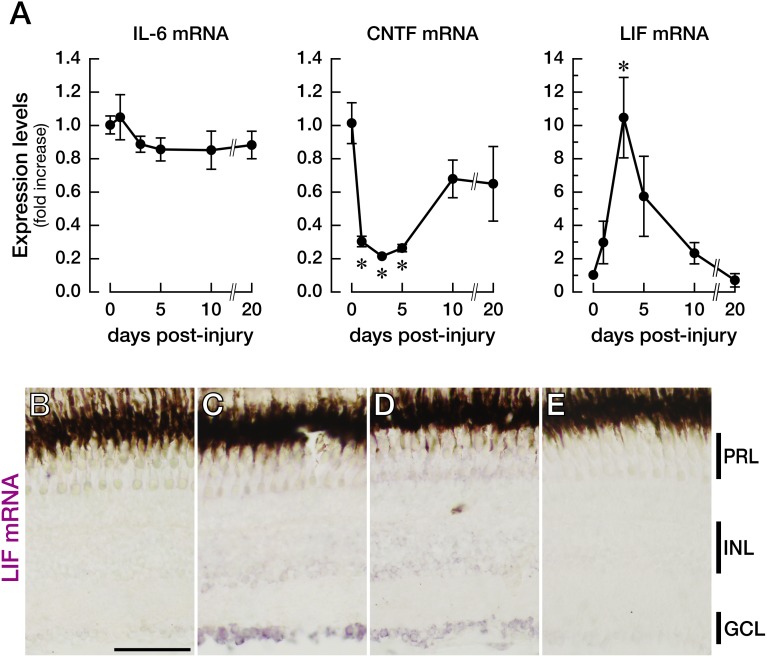
Upregulation of LIF mRNA in zebrafish RGCs after optic nerve injury.(A) IL-6 mRNA showed little or no change for at least 20 days after the nerve injury, but CNTF mRNA showed significant downregulation 1–5 days post-injury (dpi; n = 3, *p<0.01). The expression level of LIF mRNA drastically increased at 3 dpi (n = 3, *p<0.01). (B–E) In situ hybridization revealed very weak expression of LIF mRNA in the intact zebrafish retina (B). At 3 and 5 dpi, LIF mRNA was upregulated mostly in the ganglion cell layer [GCL; weakly in the inner nuclear layer (INL) and photoreceptor layer (PRL)] (C and D, respectively). Incubation with the sense probe yielded no signal even at 3 dpi (E). The scale bar in (B) is 50 µm.